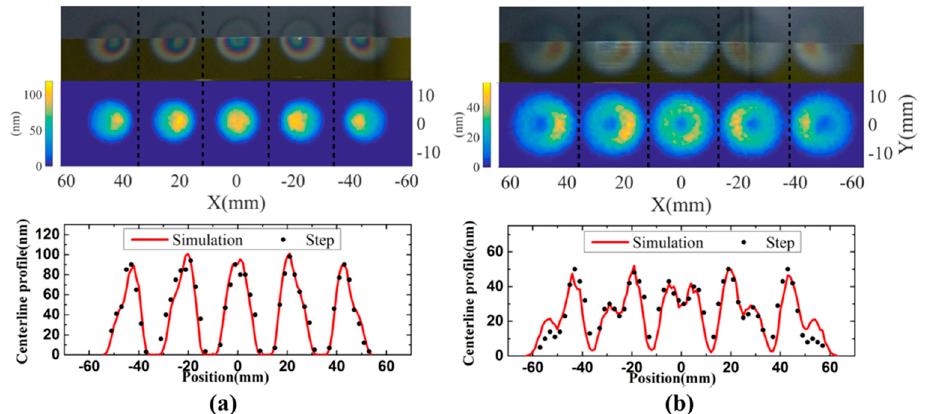
Figure 9. Comparison of different distances of the mask between the target and the substrate. ( a ) Hole diameter of 6 mm, d 1 = 62 mm, d 2 = 8 mm. ( b ) hole diameter of 6 mm, d 1 = 57 mm, d 2 = 13 mm.